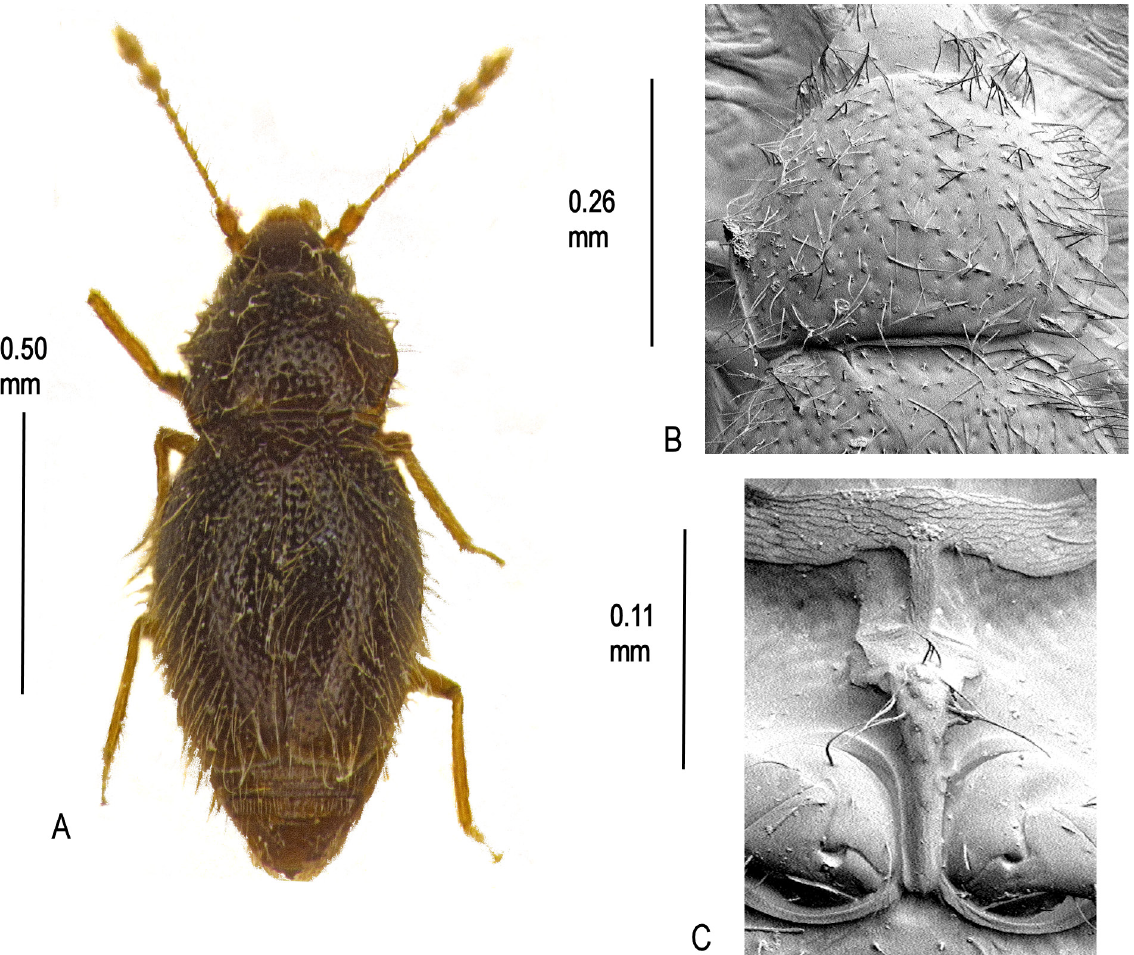
Fig. 60. Cissidium pilosellum sp. nov. A . Habitus. B . Pronotum, × 495. C . Mesoventrite showing median process of collar, mid-keel and keel, ×